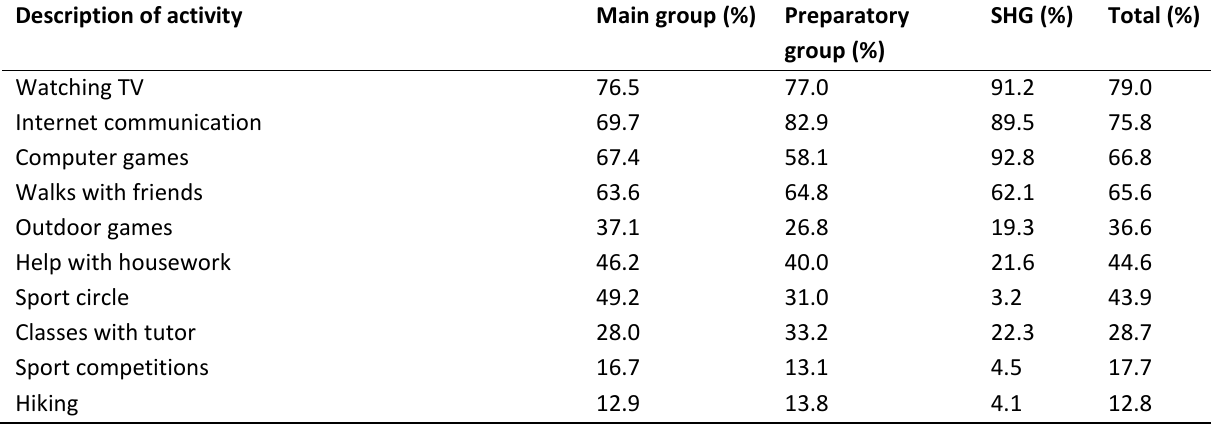
Table 1. Schoolchildren’s activities at leisure time